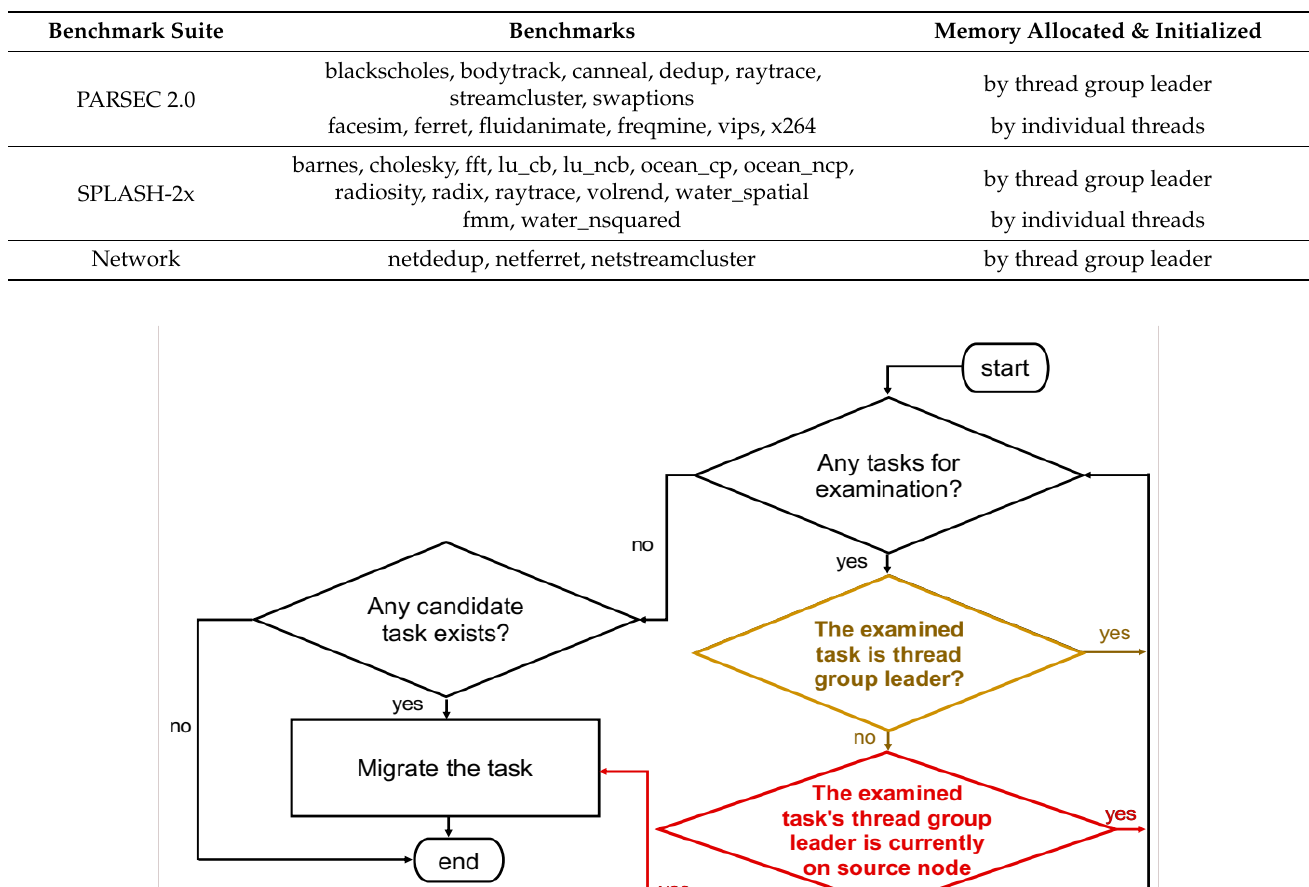
Table 2. The characteristics of benchmark programs in PARSEC 3.0.